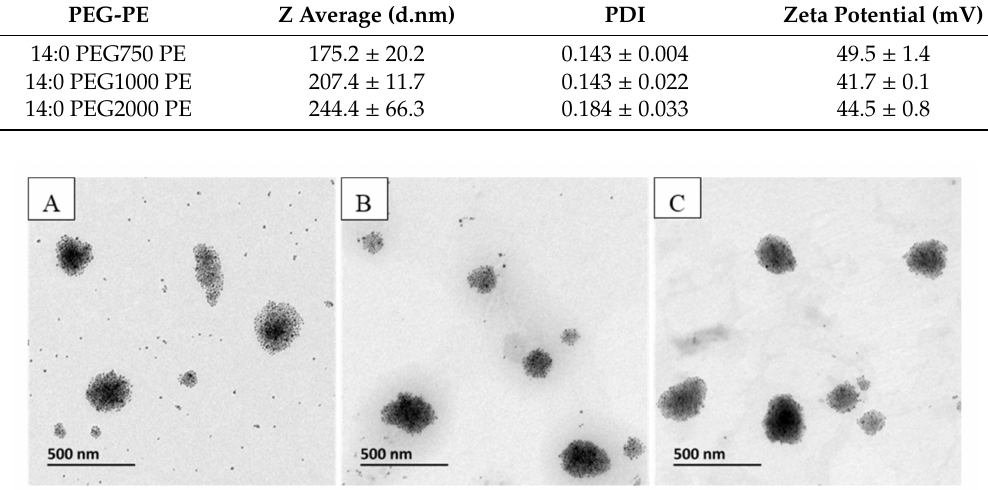
Figure 9. TEM images of MCLs prepared by the cosolvent sonication method with various PEG-PE: ( A ) 14:0 PEG750 PE; ( B ) 14:0 PEG1000 PE; ( C ) 14:0 PEG2000